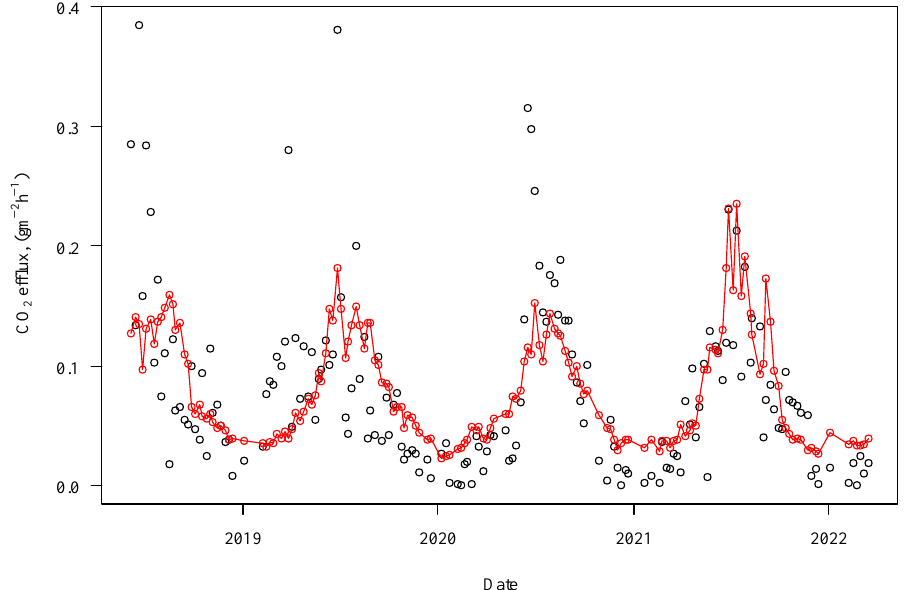
Figure 6. Outputs of the extended exponential model for the CO 2 efflux (g m − 2 h − 1 ) from undisturbed bare soil within the period of 2018–2022. Measured and calculated data are represented by black and red circles, respectively.